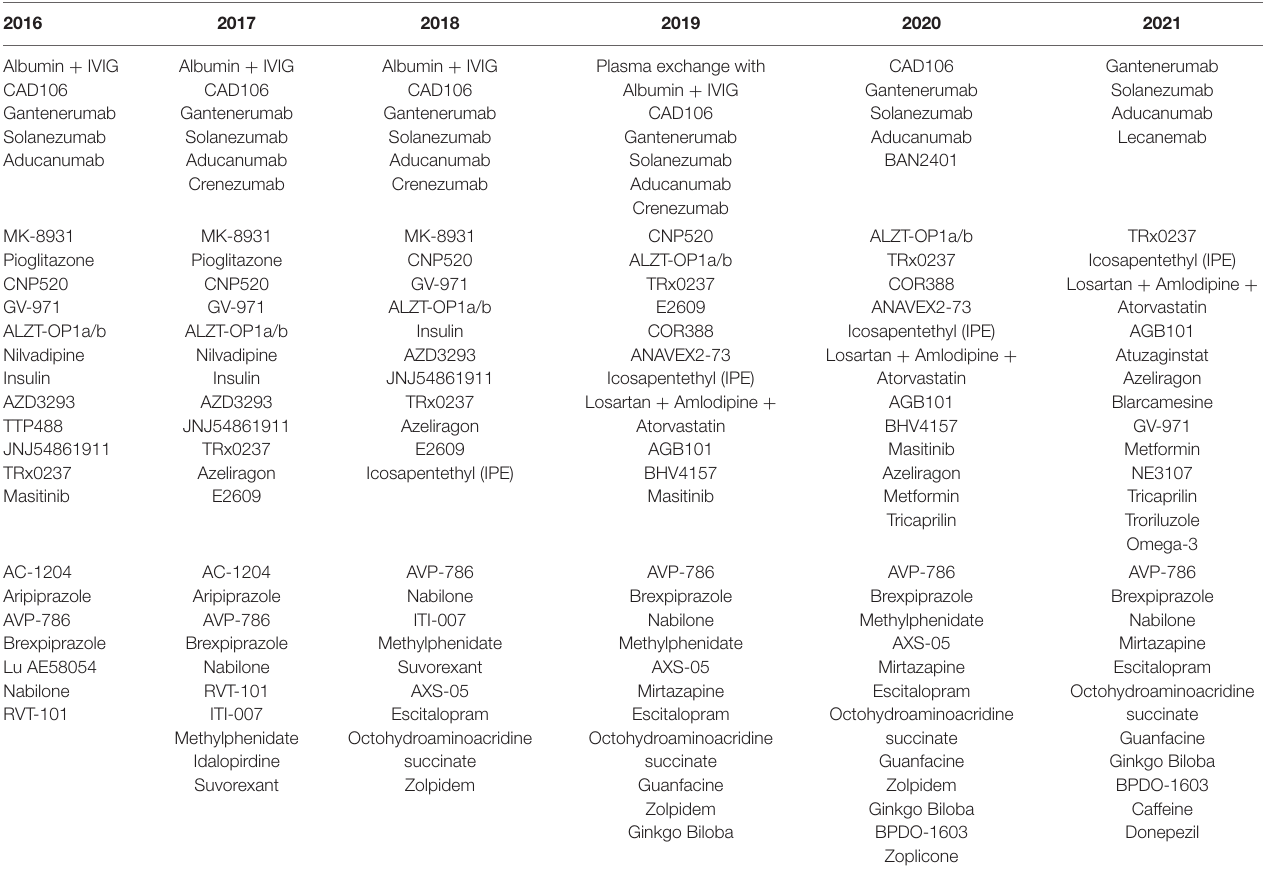
TABLE 1 | Agents in Phase 3 clinical trials from 2016 to